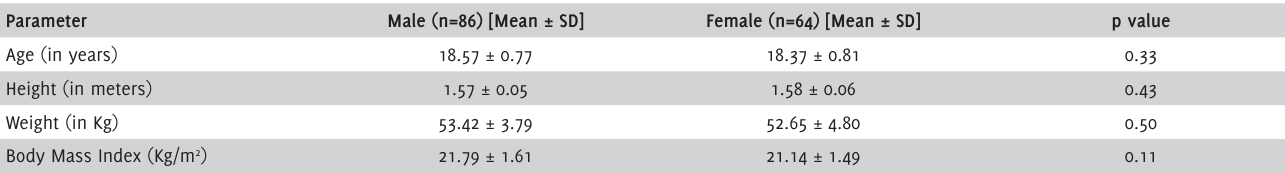
Table 1. Age and anthropometric data of the study population (Unpaired student’s t-test).